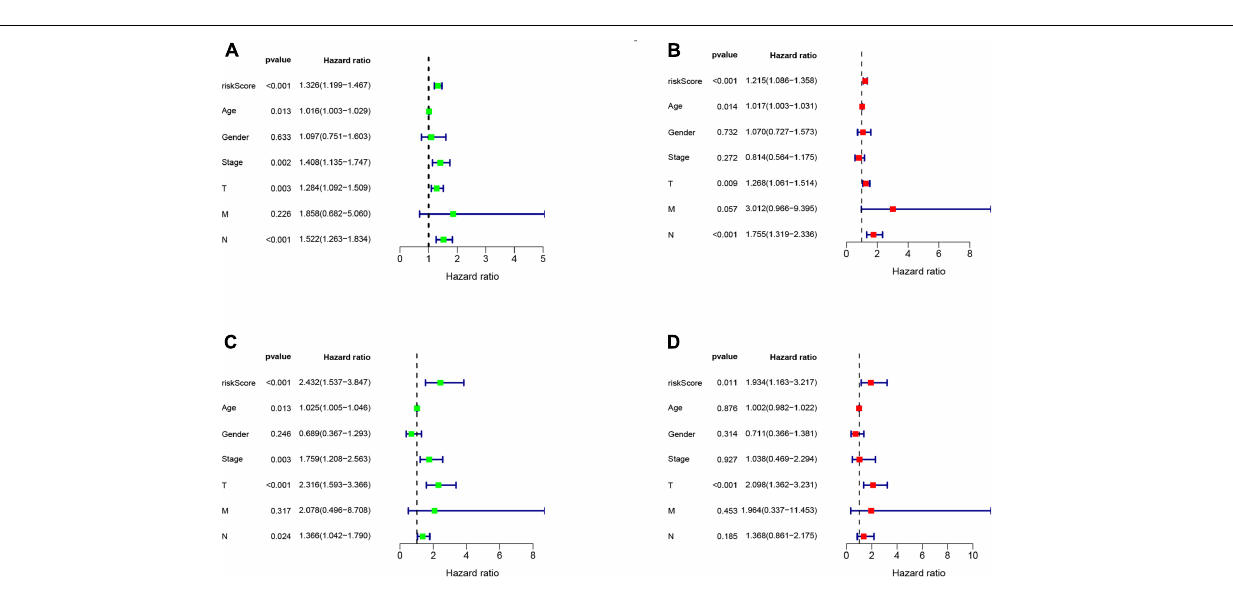
Frontiers in Cell and Developmental Biology |